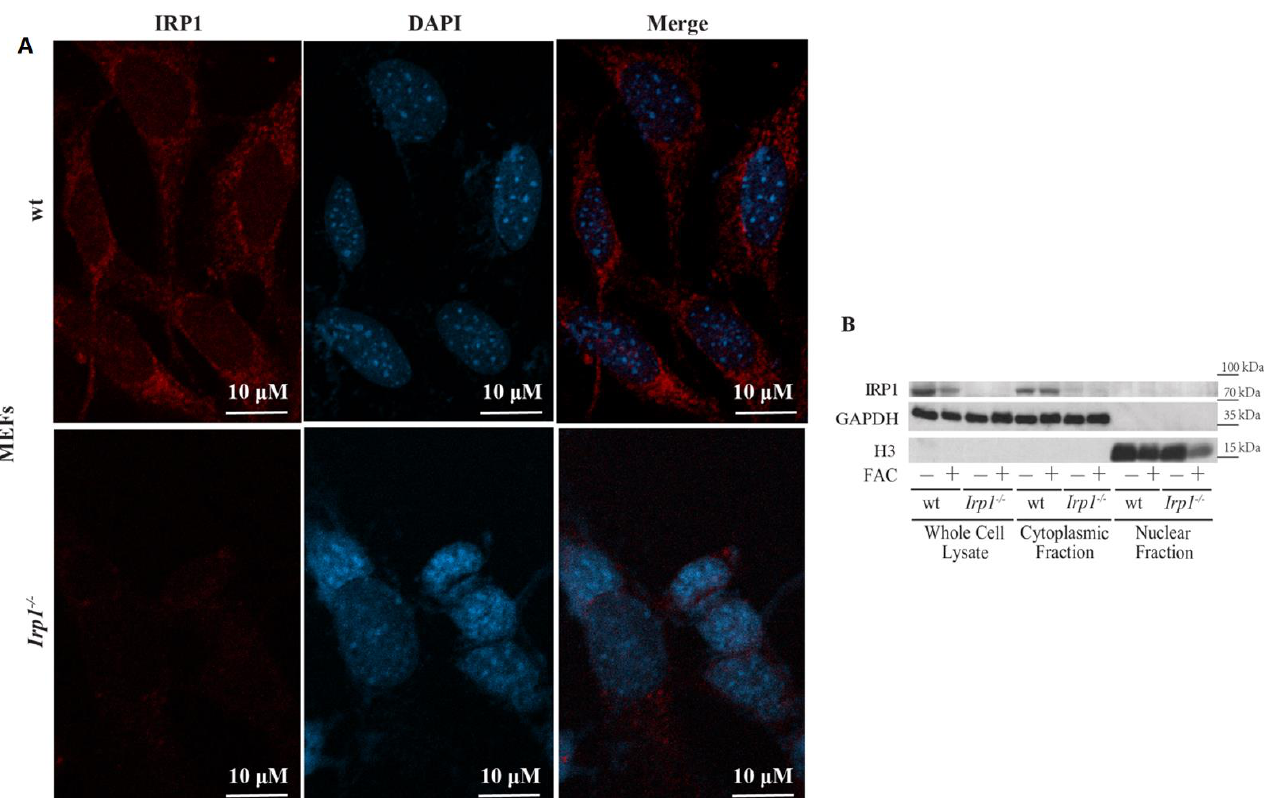
Figure 1. Subcellular IRP1 localization in immortalized MEFs. ( A ) Immunofluorescence of IRP1 in MEFs from wild type (wt) and Irp1 − / − mice pre-treated with 100 μ g/mL FAC for 18 h; nuclei are stained with DAPI. ( B ) Western blot analysis of IRP1, GAPDH and H3 in whole cell lysates, cytoplasmic supernatants and nuclear extracts from wild type and Irp1 − / − MEFs previously treated with FAC or not.